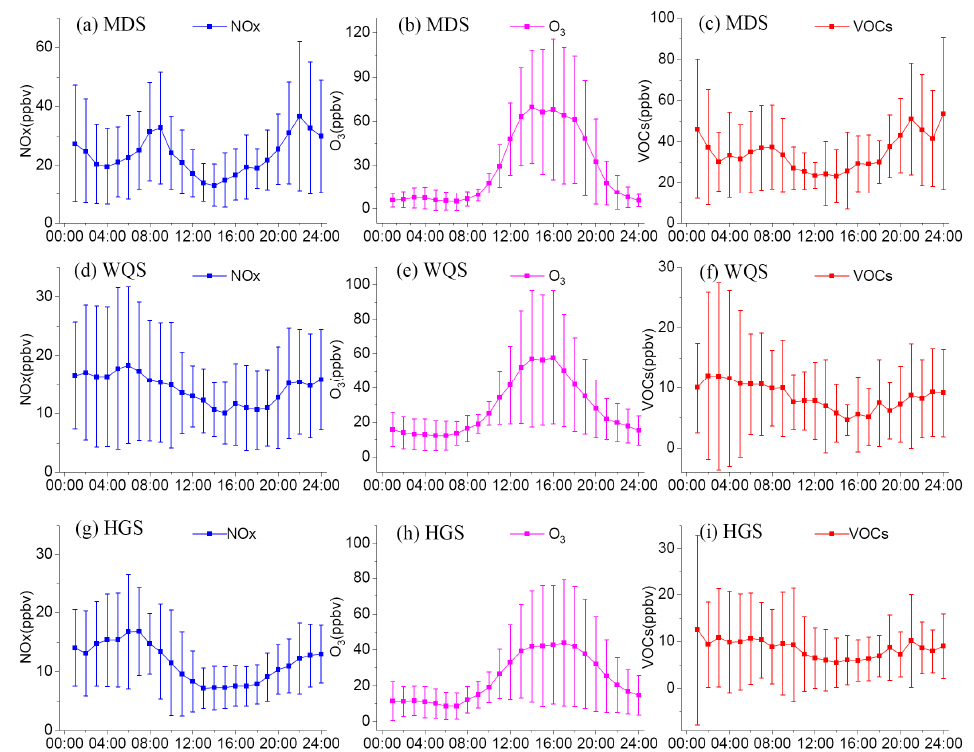
Figure 6. Diurnal variations of ( a ) nitrogen oxides (NOX) at MDS, ( b ) O3 at MDS, ( c ) VOCs at MDS, ( d ) NOx at WQS, ( e ) O3 at WQS, ( f ) VOCs at WQS, ( g ) NOx at HGS, ( h ) O3 at HGS, and ( i ) VOCs at HGS. Points represent the means. Error bars represent the standard deviations.